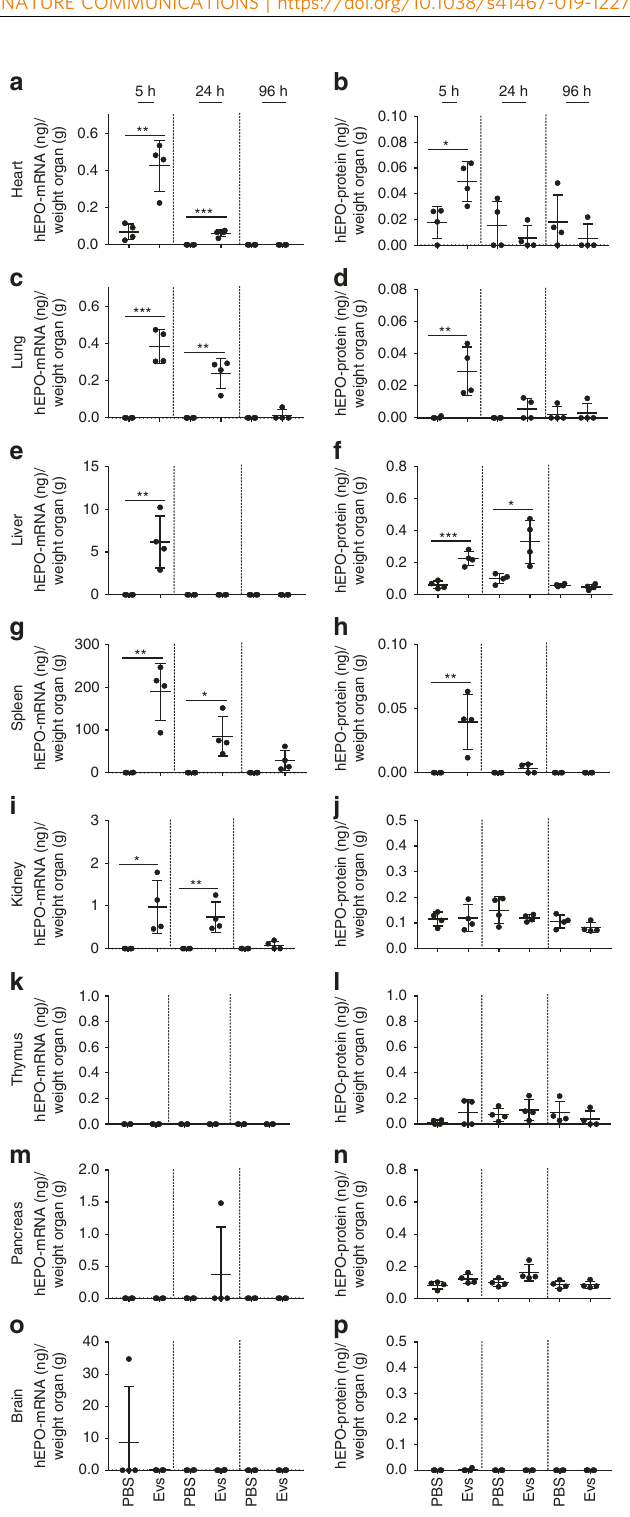
ionizable lipids per mole of hEPO mRNA nucleotides. This dif- fered from LNPs, which contained three moles of ionizable lipids per mole of hEPO mRNA nucleotides. Despite variation in the levels of EPO-mRNA and ionizable lipids in endo-EVs, the molar ratio between them remained the same (1:1). These results together with the results of the cell free mixture of EVs and LNPs indicated that LNPs do not fuse with EVs outside the cell, but rather processed in the endosomal pathway and are secreted in endo-EVs.